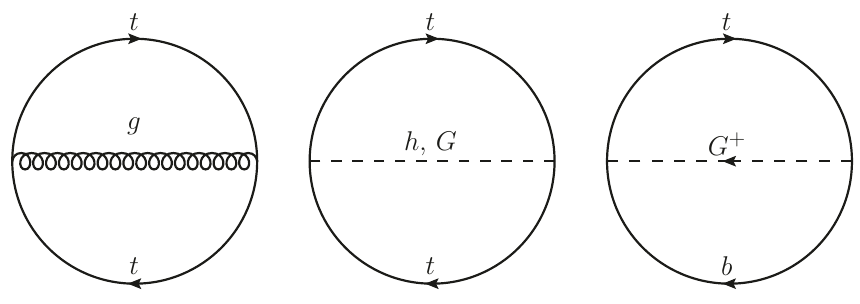
Figure 1 . Dominant two-loop diagrams contributing to the SM effective